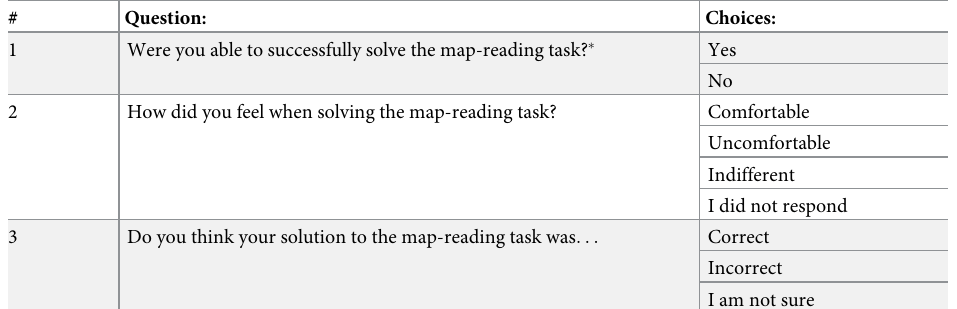
Table 5. Follow-up questions after map design variation ( � this question was included for evaluating a possible response